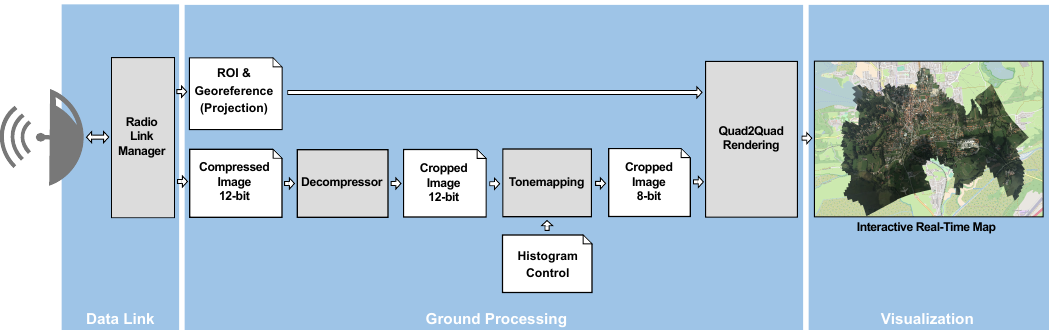
Figure 1. Airborne segment of real-time processing chain. The particular processing stages are explained in Section 2.